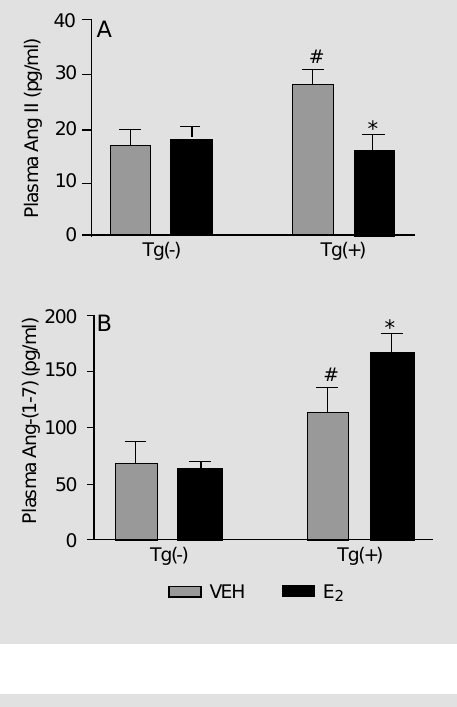
Figure 6 - Effect of estrogen re- placement (E 2 ) on plasma (A), kidney (B) and thoracic aorta (C) levels of angiotensin converting enzyme. Estrogen reduces the plasma angiotensin converting enzyme activity in Tg(+) and Tg(-) animals, whereas it only re- duces the tissue levels of kidney and thoracic aorta in Tg(+) rats. Values are reported as mean ± SEM. *P<0.05, VEH vs E 2 (Tukey-Kramer test). Each group included 6~8 rats. VEH = Ve- hicle. (Reproduced from Ref. 62 with